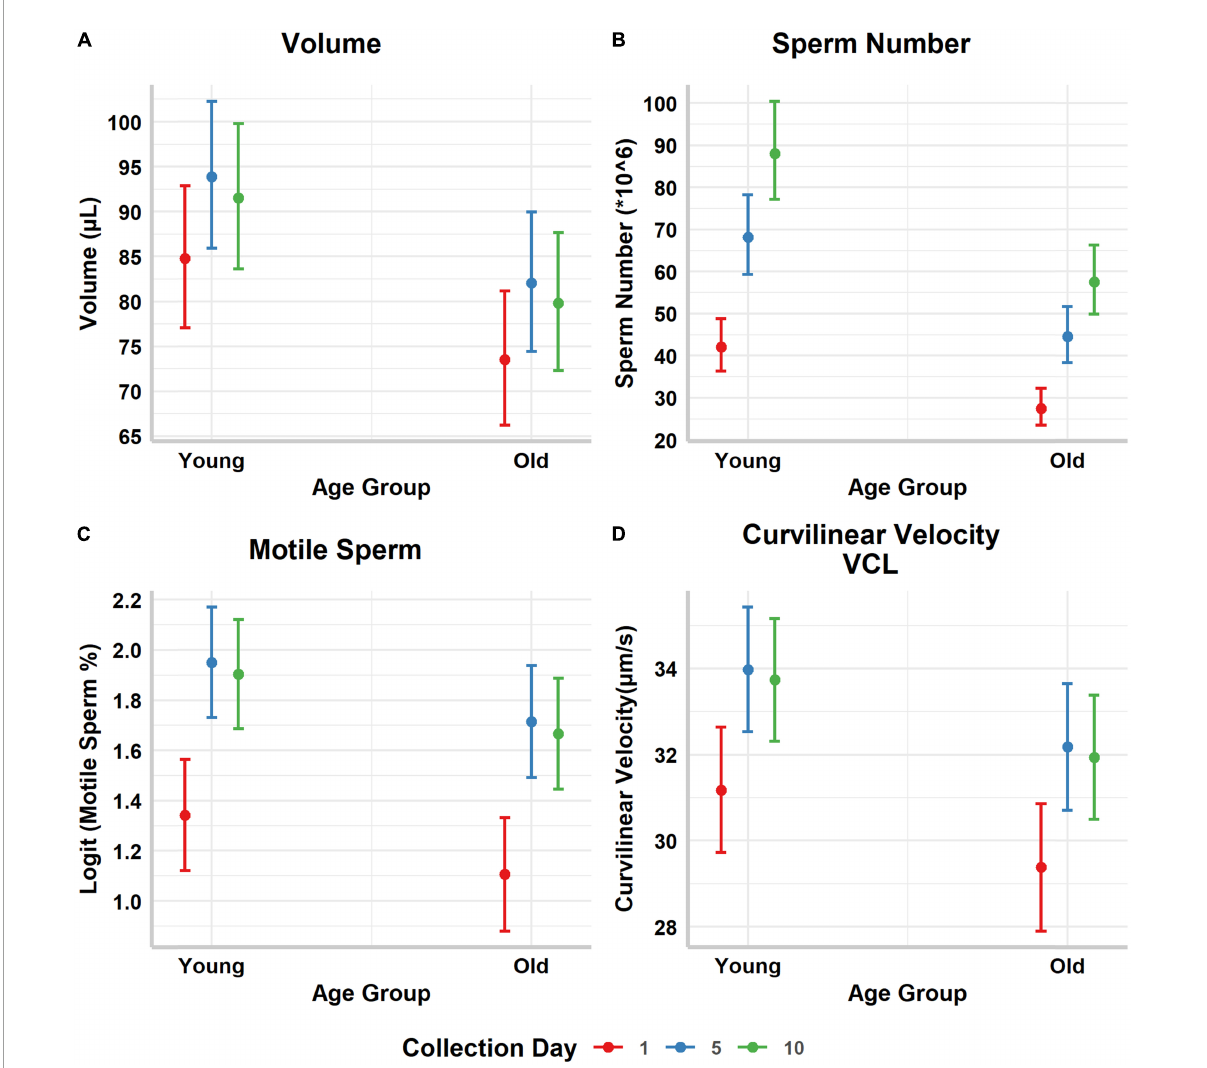
FIGURE1 Predicted marginal means and their corresponding 95% confidence intervals of the (A) ejaculate volume ( µ L), (B) number of sperm in the ejaculate ( × 10 6 ), (C) percentage of motile sperm (on the logit scale), and (D) curvilinear velocity, per male (old vs. young) and sperm age. Collection day refers to the day sperm was collected after a common initial collection, and it is used as a proxy of sperm